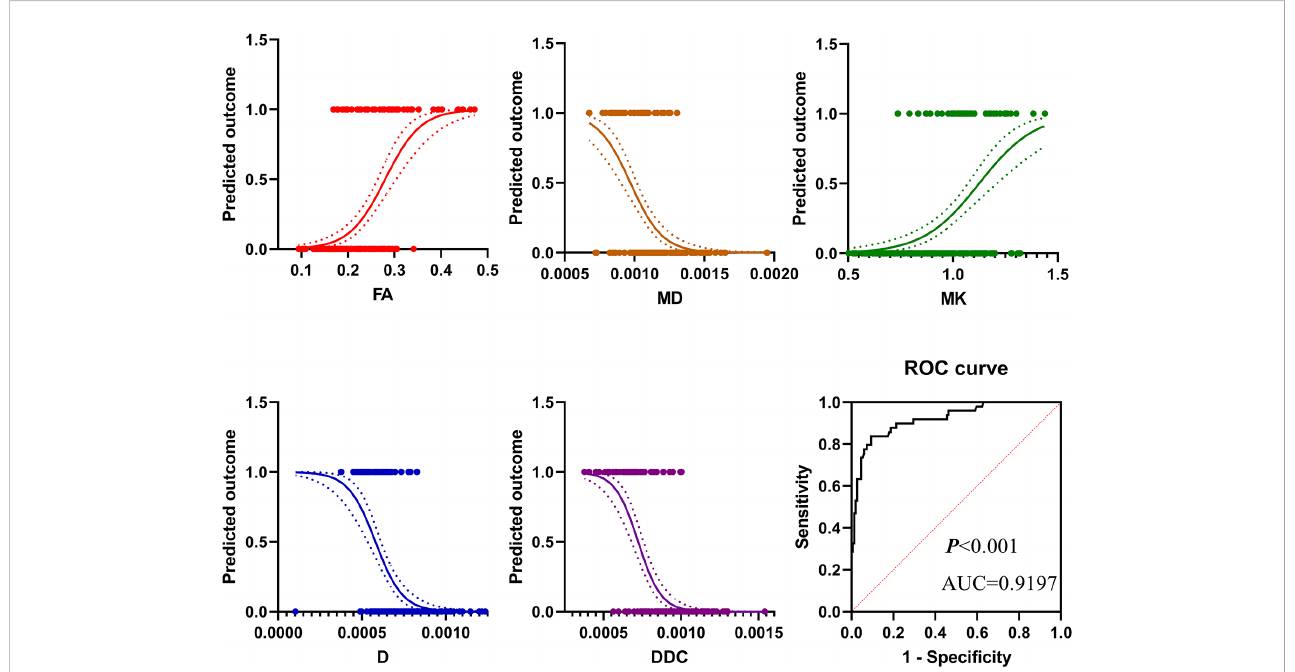
FIGURE 6 The results of binary logistic regression analysis showed that in pi-rads 3 lesions, the prevalence of PCa increased with the increase of FA value and MK value but decreased with the increase of MD value, D value, and DDC value. The diagnostic ef fi ciency in distinguishing PCa from PI-RADS 3 lesions of these parameters was 0.9197.